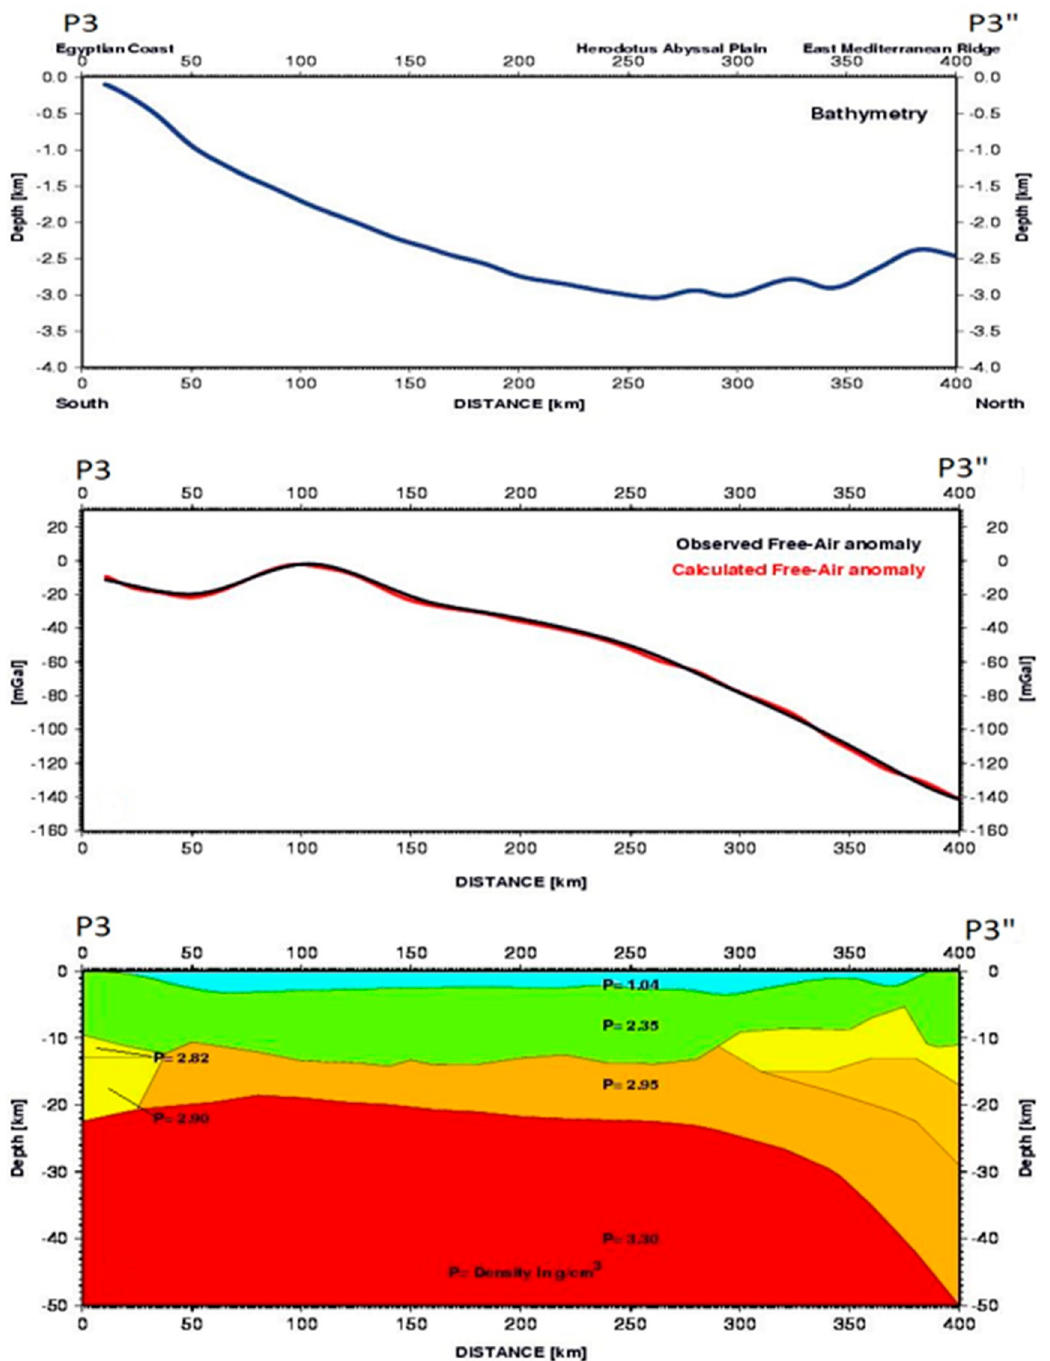
Figure 6. 2D modelling gravity along profile P3–P3 ″ .